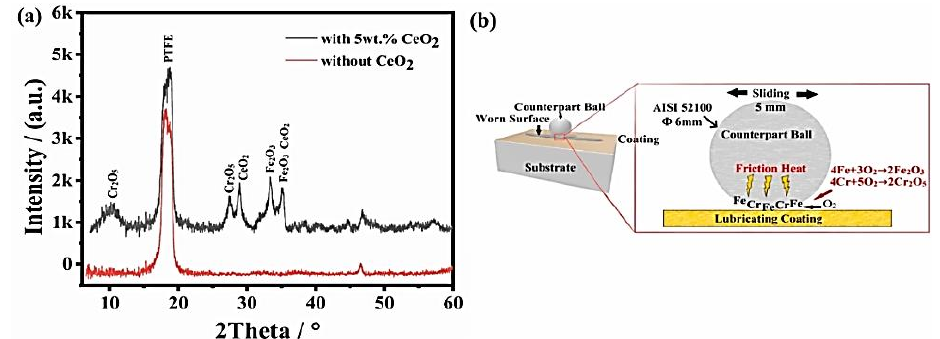
Figure 10. ( a ) Results of XRD analysis of the worn ‘PAI + PTFE’ coating surface and ( b ) a scheme of the tribochemical reactions. Figure is reproduced with permission from reference [57].